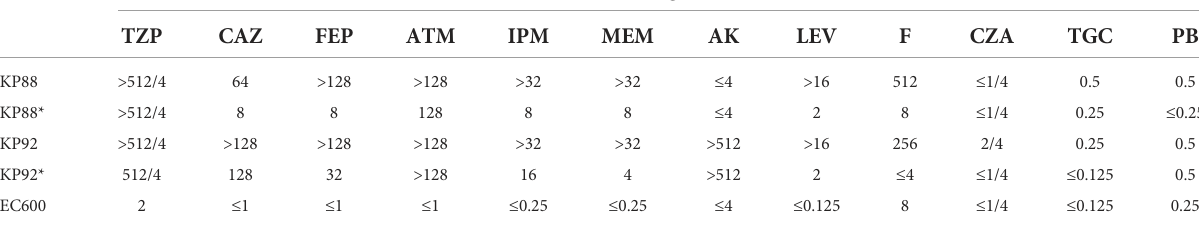
TABLE 3 Susceptibility of KP88, KP88*, KP92, KP92*, and EC600.